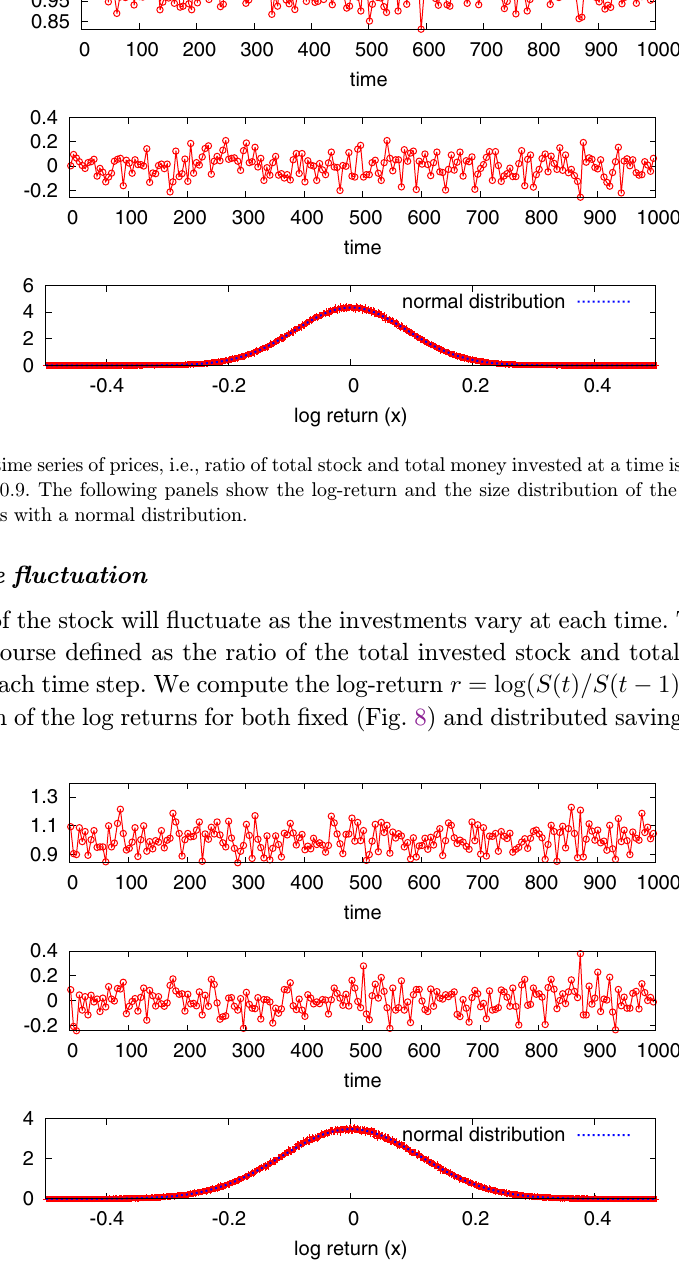
Fig. 9. The price °uctuations, log-return and its size distribution are plotted for uniformly distributed saving propensities.